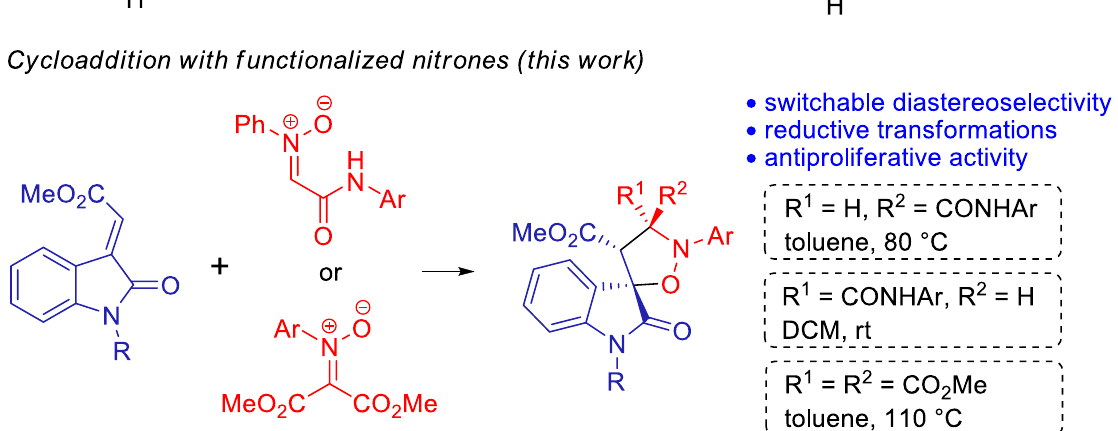
Scheme 1. The 1,3-dipolar cycloaddition of 2-(2-oxoindoline-3-ylidene)acetates with